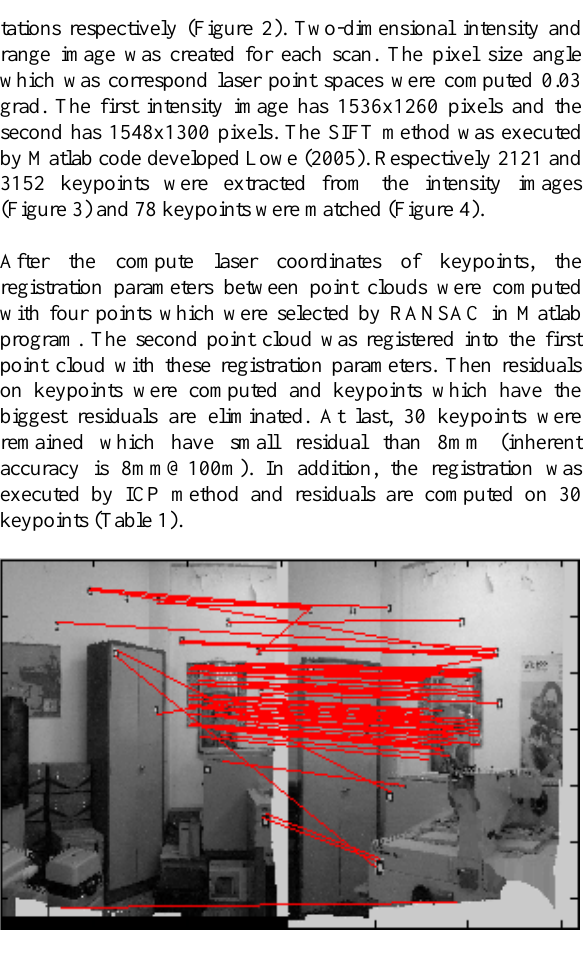
Figure 4. Total 78 keypoints were matched by SIFT parameters. Tablo 1: After the registration by ICP and intensity image methods, min and max residuals on keypoint